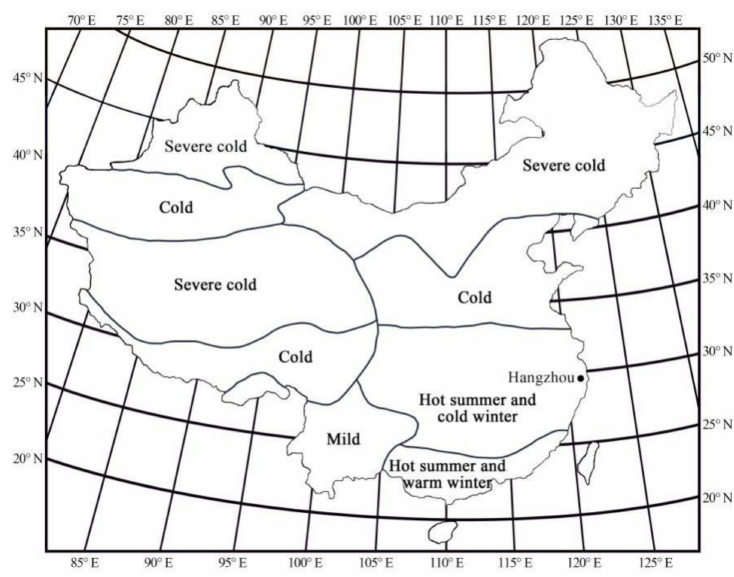
Figure 1. Layout of five climate zones in China and the survey city.